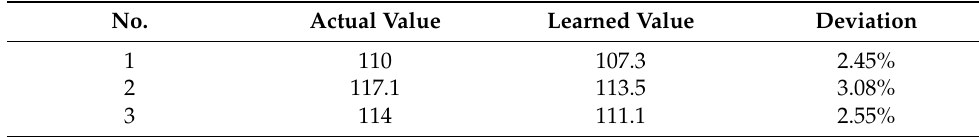
Table 3. Train mass learning results.